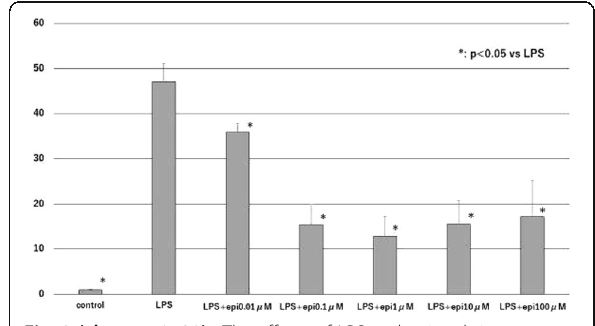
Fig. 2 (abstract 0130) . The effects of LPS and epinephrine on TNF- α